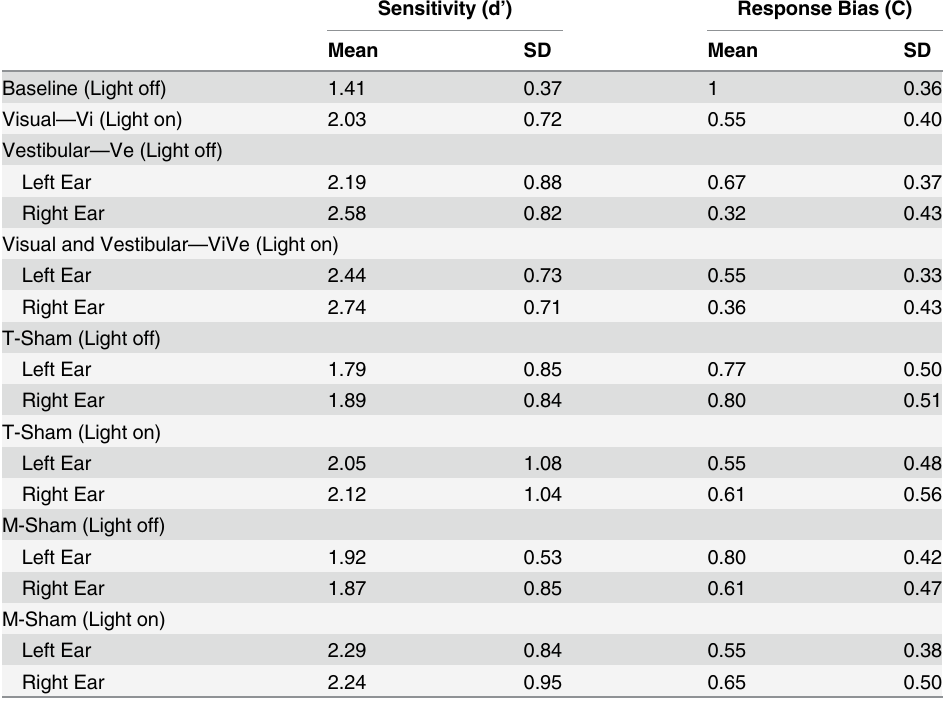
Mean and standard deviation for sensitivity and response bias in each experimental